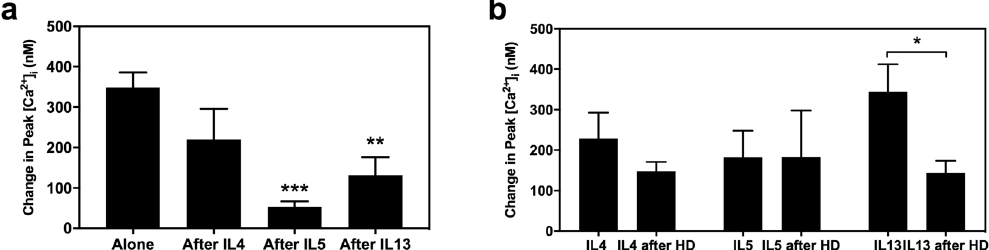
Figure 5. Effect of IL pre-treatment on increase in intracellular [Ca 2 + ] ([Ca 2 + ] i ) stimulated by the H1 agonist histamine dimaleate (HD) in rat conjunctival goblet cells. Peak [Ca 2 + ] i over basal produced by the addition of 10 − 5 M HD after a pre-treatment with IL4, IL5, or IL13 each at 10 ng/ml for 2.5 min ( a ) or by the addition of IL4, IL5, or IL13 alone or after a pre-treatment with 10 − 5 M HD ( b ). Data are expressed as means ± SEM from five